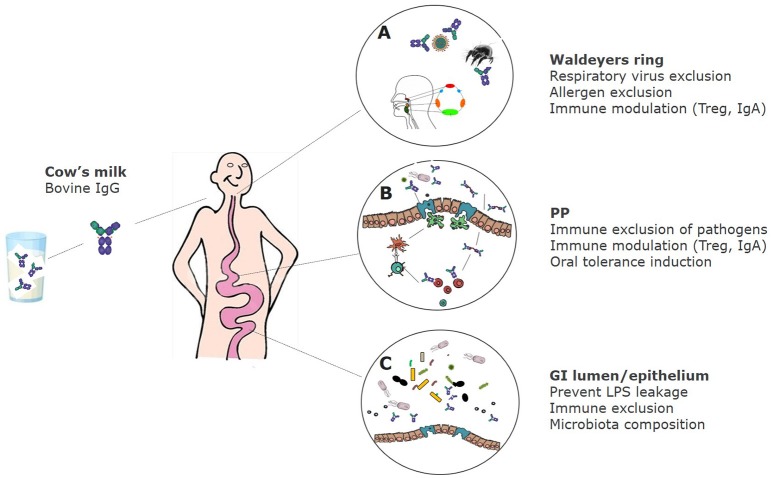
Proposed effects of bovine IgG at various locations in the GI tract. (A) After ingestion bovine IgG can encounter swallowed respiratory pathogens and inhaled allergens. This can lead to partial immune exclusion (especially when milk is regurgitated and enters the nasopharynx) and immune modulation in the tonsils that comprise Waldeyer's ring. (B) In the small intestine IgG can also exclude pathogens by preventing adhesion to epithelial surfaces, but may also promote the uptake of immune complexes of IgG with pathogens via Fc receptors, resulting in regulatory immune responses and induction of IgA. (C) In the colon, IgG prevents leakage of LPS, can modify microbiota composition and short-chain fatty acids (SCFA) production, and can prevent adhesion of pathogens.